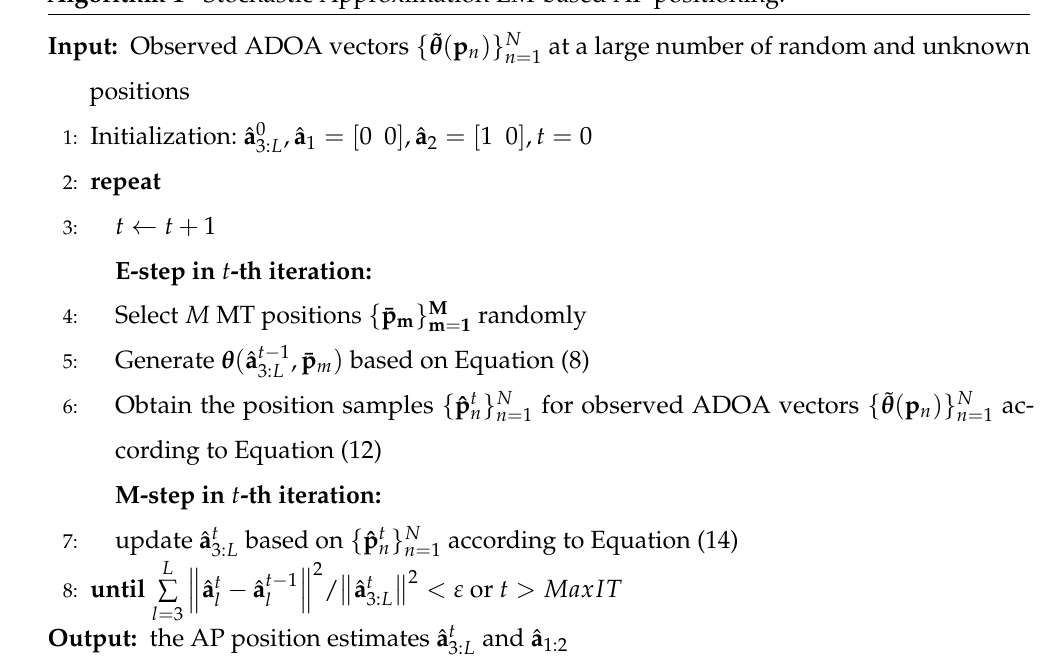
Algorithm 1 Stochastic Approximation EM-based AP